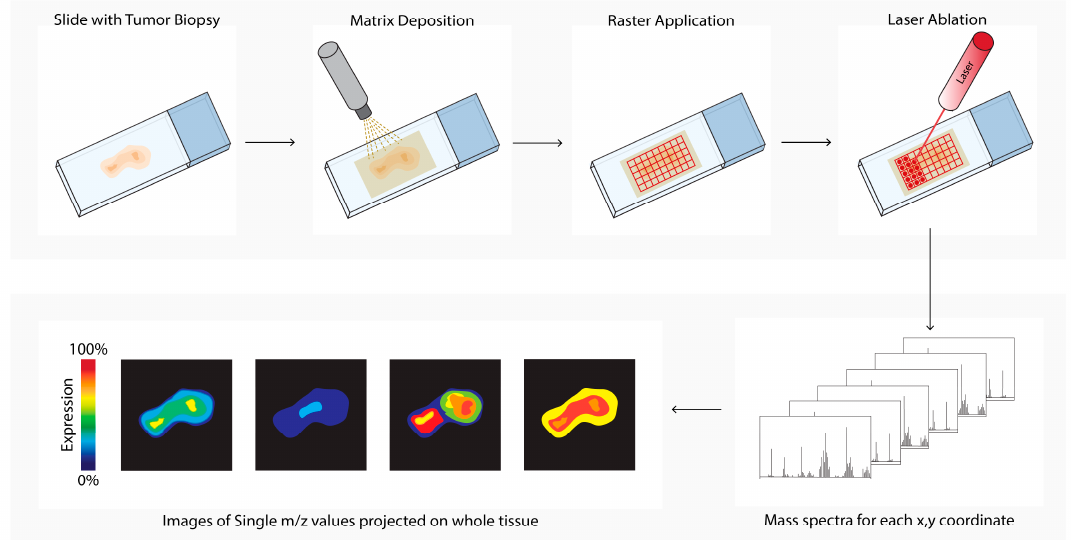
Figure 6. Matrix-assisted laser desorption ionization mass spectrometry imaging (MALDI-MSI) workflow. Tissue sections are processed, and a matrix is applied (matrix deposition). Next, a laser in the MALDI-MSI creates a 10–150 micrometer raster (Raster Application). The laser beam ionizes a spot in each raster (laser ablation), and the ionized analytes from the raster are transferred into the mass spectrometer for compound identification (mass spectra). In parallel, an image is created by combining the data of the spot location with the corresponding measured mass spectrum (images of single m/z